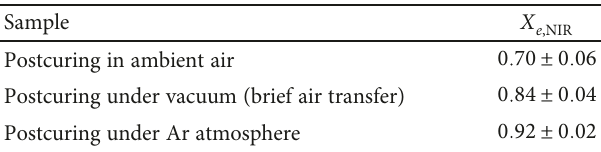
Table 1: Results obtained by FTIR spectroscopy using di ff erent experimental conditions for postcuring.